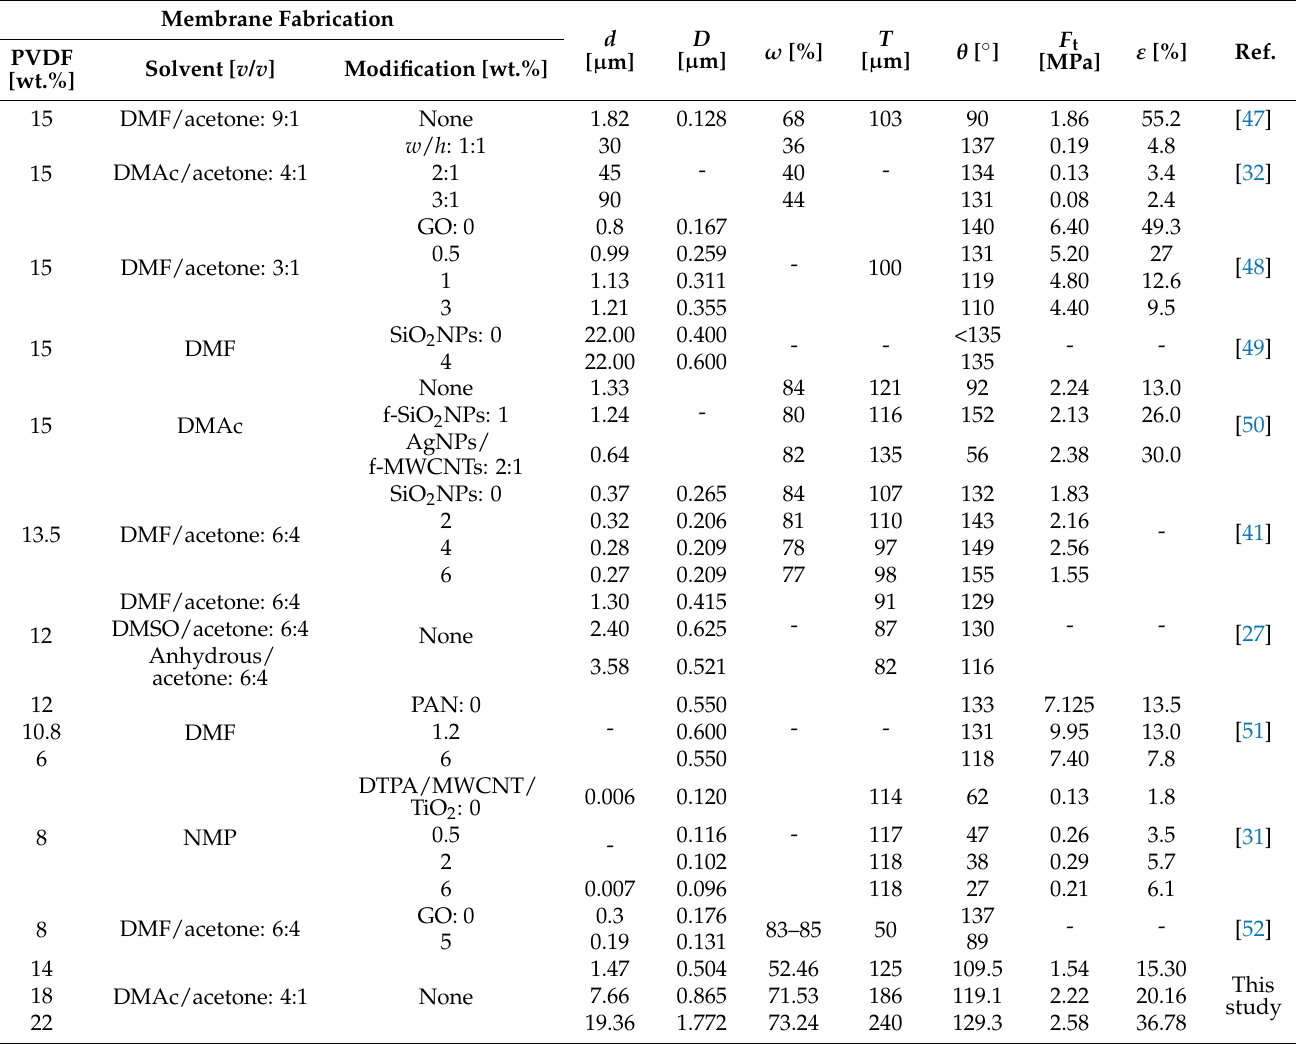
Table 1. Typical parameters for previously reported ENMs fabricated using PVDF over the last 5 years and the PVDF ENMs fabricated in this study *. d : pore size; D : fiber diameter; ω :